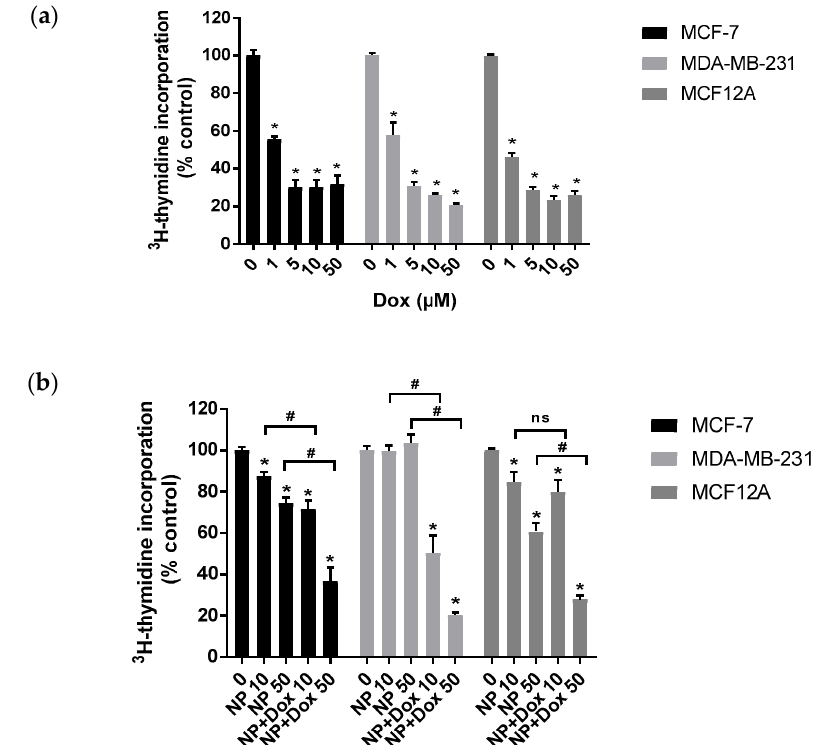
Figure 8. Cell proliferation after exposure for 24 h to ( a ) free doxorubicin ( μ M) and ( b ) unloaded nanoparticles (NP) and nanoparticles loaded with DOX (NP + DOX; μ M), for all cell lines. Shown are arithmetic means ± SEM ( n = 6). ( a ) * significantly different from control ( p < 0.05; Student’s t test). ( b ) * significantly different from control; # significantly different from each other ( p < 0.05; ANOVA + Student-Neuman–Keuls test); ns not significant ( p < 0.05; ANOVA + Student-Neuman–Keuls test).